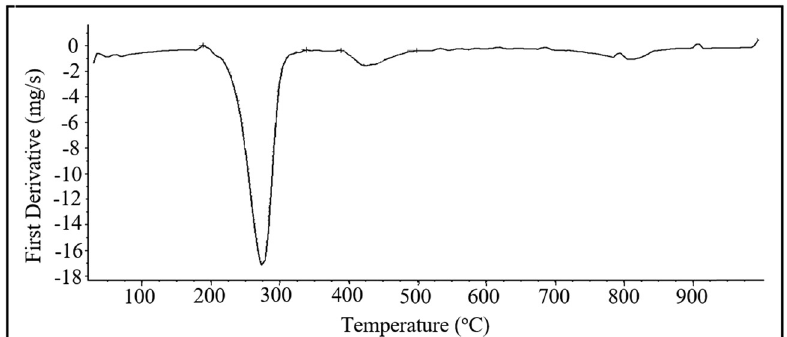
Figure 9: DTGA thermogram of the as - received